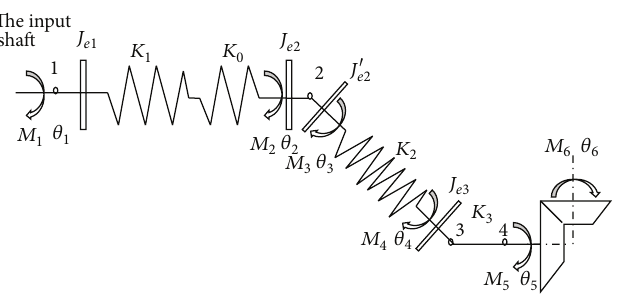
Figure 2: Torsional vibration analysis model of the transmission shaft, driving gear, and driven gear